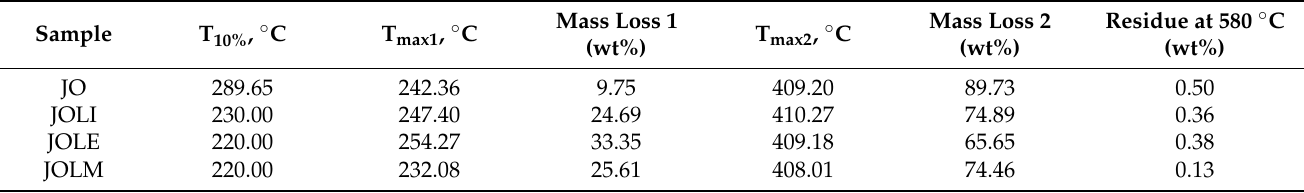
Table 3. The results of thermogravimetric analysis.